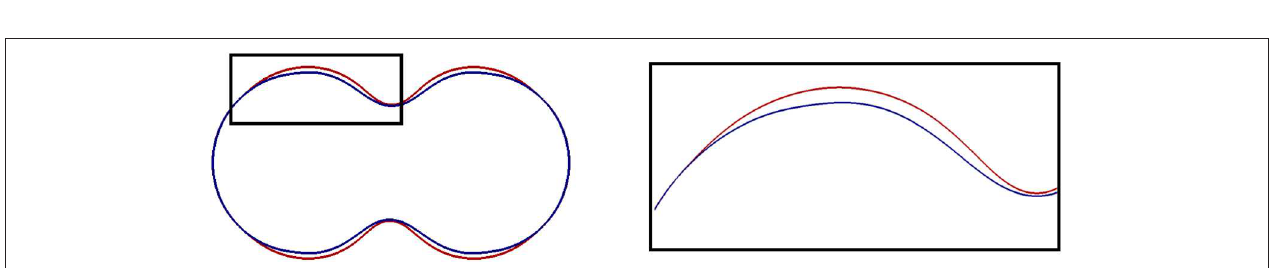
FIGURE 6 | Slices through the central axis of shapes obtained in simulations that we report on in section 5.3. A magnified image of the black box is presented on the right. The final shapes for two computations are displayed. One for the standard parameters in Table 1 (blue), and one with x 0 increases the membrane tension but also reduces the area at which the membrane is at rest (see Equations (50), (51) and in between). In the concave region of the initial surface the membrane thus moves farther and its area shrinks further than before.